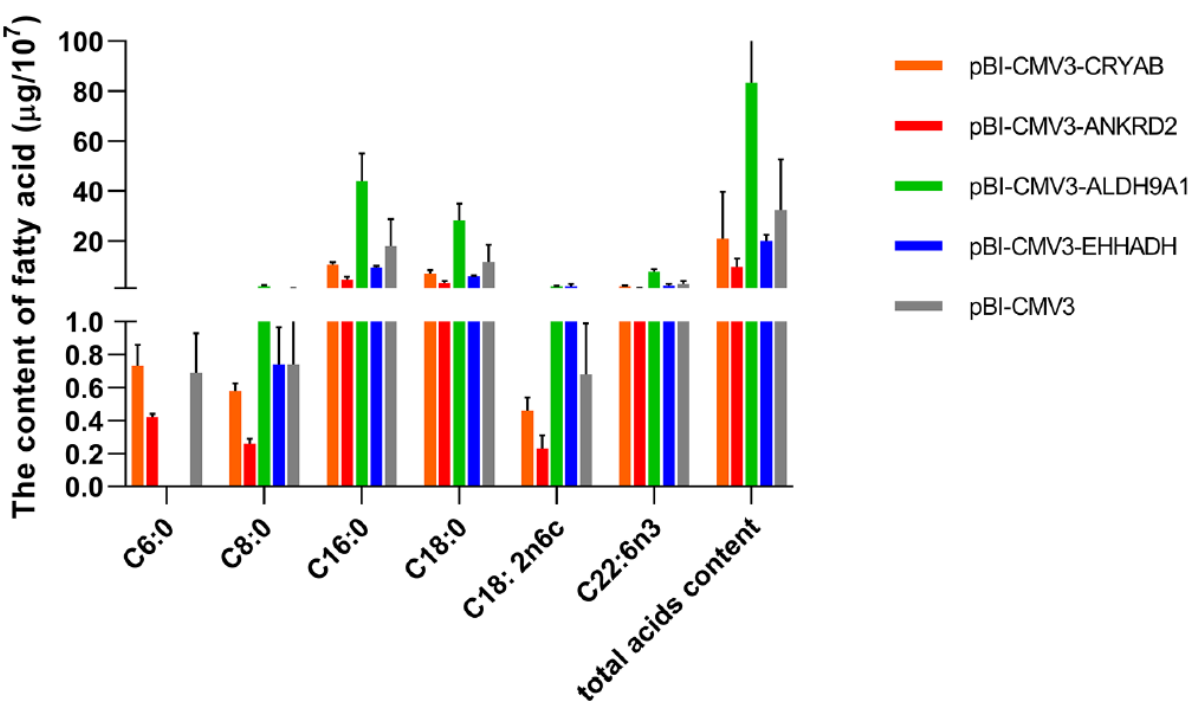
Figure 4. The composition of fatty acids 48 h after transfection. C6:0: caproic acid; C8:0: caprylic acid; C16:0: palmitic acid; C18:0: stearic acid; C18:2n6c: linoleic acid; C22:6n3: cis-4,7,10,13,16,19- docosahexaenoic acid.